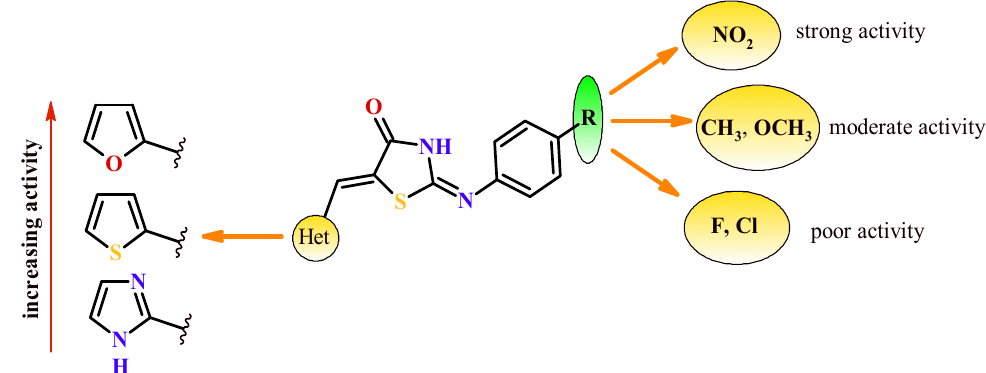
Figure 32. The 5-Heterylmethylidenethiazolidin-4-ones with PTP1B inhibitory activity. Based on SAR analysis, there is the conclusion that presence of furan ring at Position 5 of thiazolidin-4-one ring is more preferable than two other heterocycles (thiophen and imidazole) for PTP1B inhibitory activity. The compounds ( 75e , 76e and 77e ) with nitro group in para position of phenylamine moiety were most active and showed PTP1B in- hibitory activity better than reference drug suramin with IC 50 values 6.42, 5.88 and 7.93 µ M, respectively. The moderate inhibitory effect was exhibited by derivatives ( 75c , 75d , 76c , 76d , 77c and 77d ) with methyl and methoxy groups in phenylamine moiety. The presence of the electron-withdrawing groups (Cl, F), except Compound 76a , reduced the activity. The same trends were observed in computational results. The SAR of compounds ( 75a – 77e ) are illustrated in Figure 33.